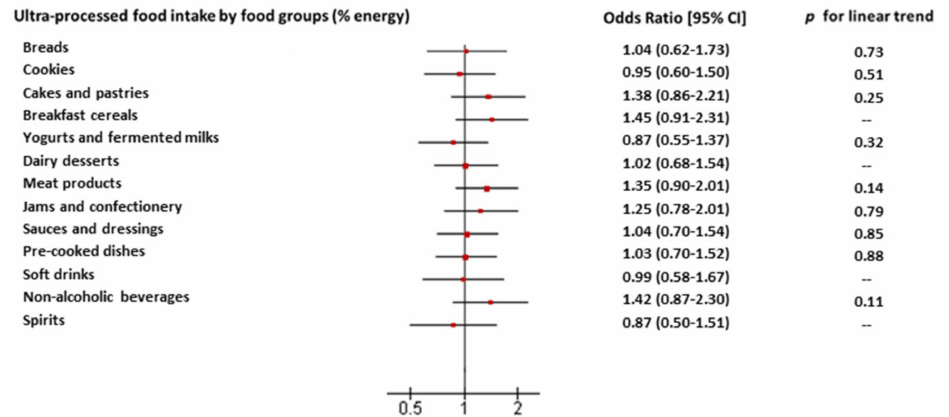
Figure 2. Odds ratio of renal decline risk and 95% confidence intervals (95% CIs) for tertile 3 (highest intake) of groups of ultra-processed food consumption as a percentage of total energy (% of energy) versus tertile 1 (lowest intake), in the Seniors-ENRICA 1 cohort study, n = 1312. When the intake of ultra-processed food from a specific food group occurred in less than 25% of the participants, the odds ratio (95% CI) was calculated between subjects who consumed the food compared to those who did not (as in breakfast cereals, dairy desserts, soft drinks and spirits). p for linear trend was calculated using tertiles as a continuous variable. Adjustments as in model 3. Other non-alcoholic